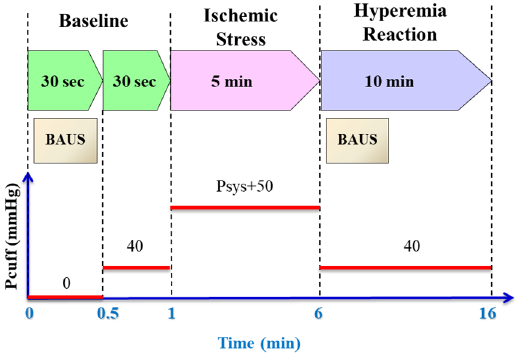
Figure 3. The experimental protocol consists of a 30 s baseline, 5 min ischemic stress and 10 min hyperemia reaction.